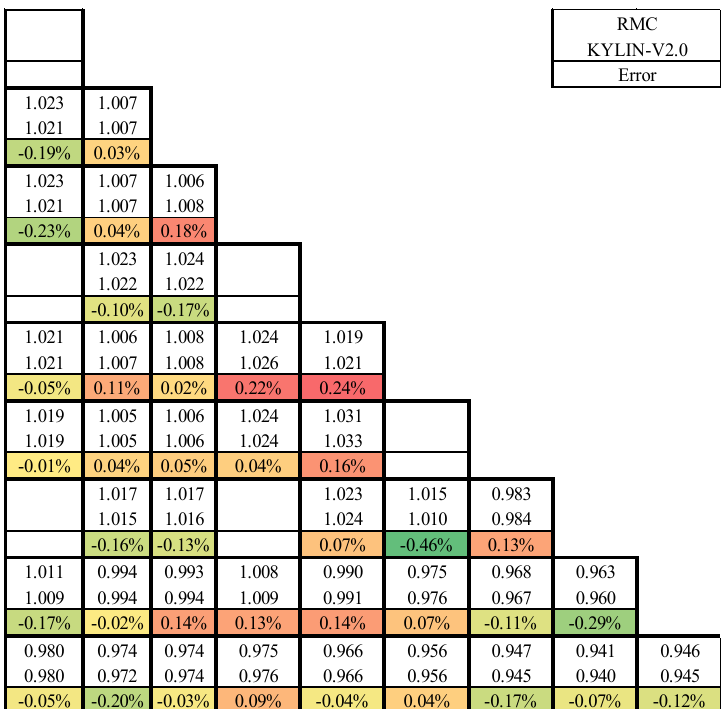
Figure 10. VERA 2B fuel assembly pin power distribution at 30 GWd/tU